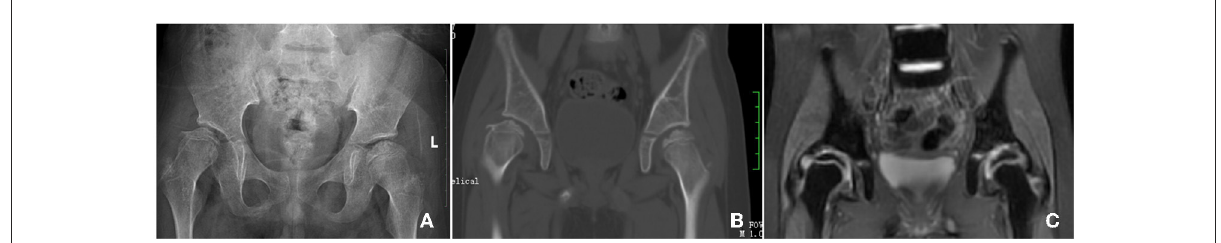
FIGURE3 Follow up Imaging examination, X-ray shows the shape of the femoral head was remodeling (A) ; the follow up CT result shows the microcystic area was replaced by normal bone tissue (B) ; the follow up MRI result shows the multiple small patchy T2WI hyperintensity shadows under the right femoral metaphysis was disappear (C)